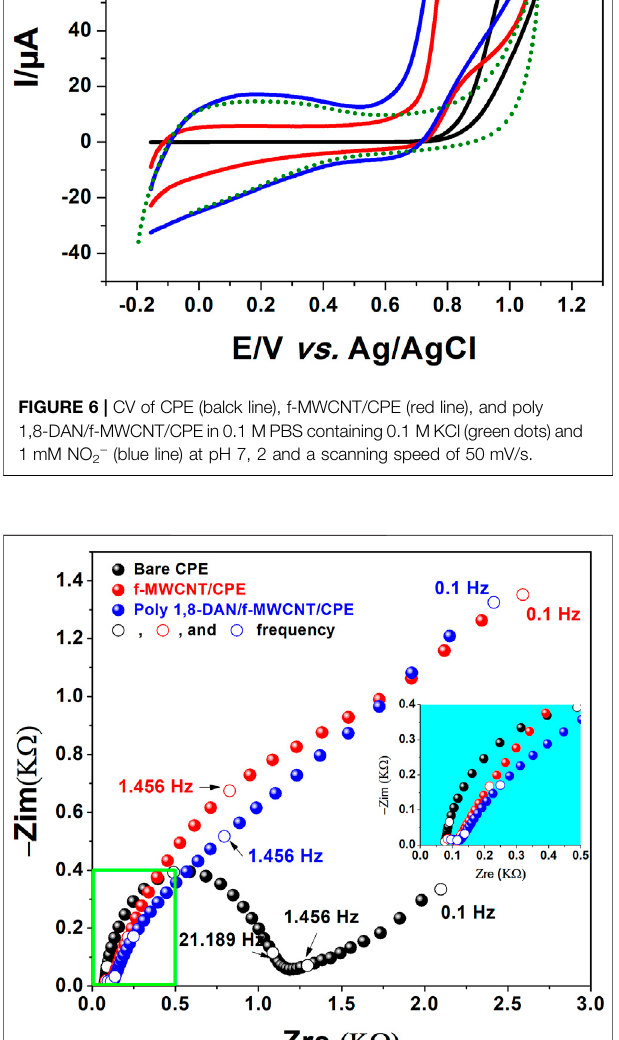
Frontiers in Chemistry |